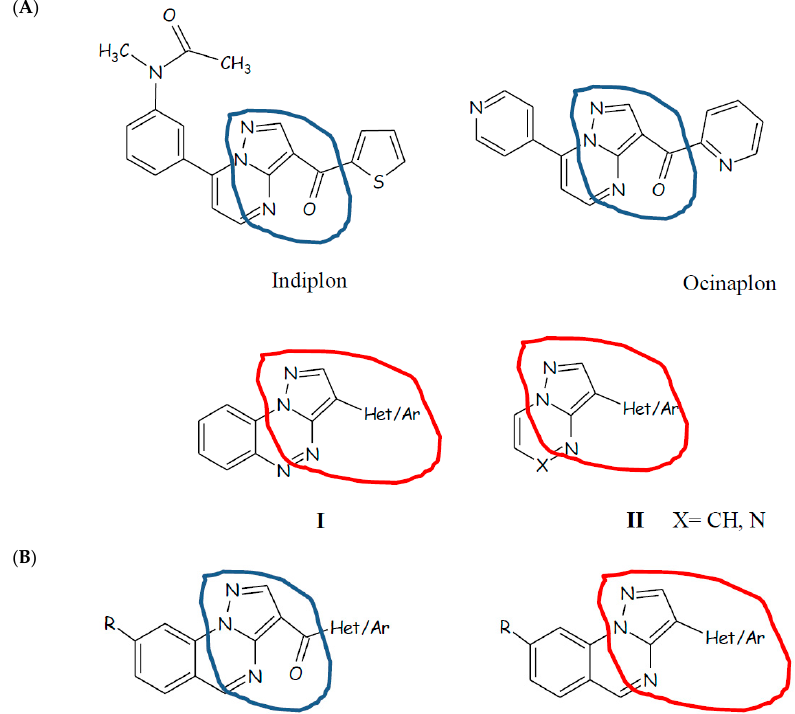
Figure 1. Panel ( A ): γ -aminobutyric type A (GABA A ) receptor subtype ligands with chemical structures strictly related to the new pyrazoloquinazoline (PQ). Panel ( B ): general structure of new synthesized PQ compounds. Blue circle 3-aroylpyrazolopyrimidine moiety; Red circle 3- arylpyrazolopyrimidina moiety.